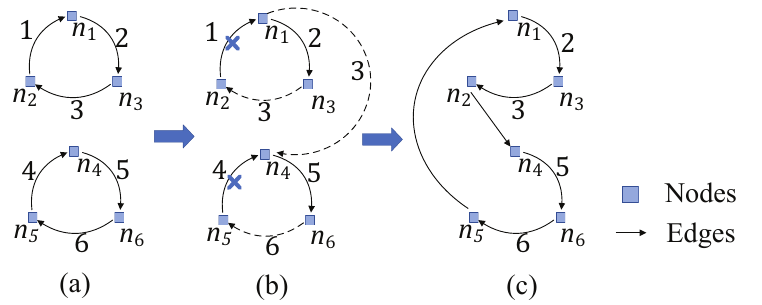
Figure 5. A simple execution process of the Algorithm 2. ( a ) initial state. ( b ) computing M. ( c ) find maximum